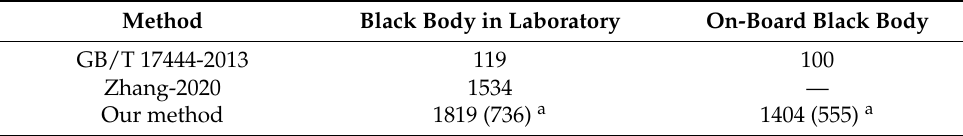
Table 1. Number of detected blind pixel using different methods.